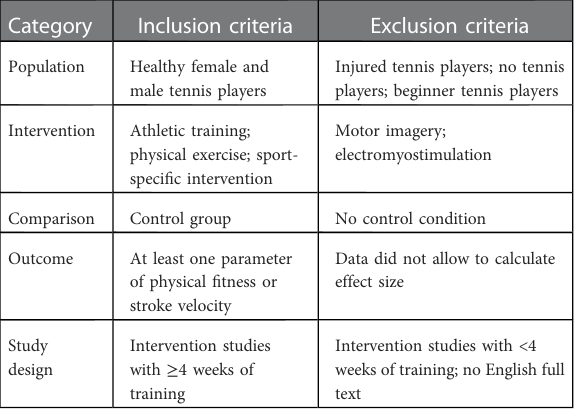
TABLE 1 Overview of the inclusion and exclusion